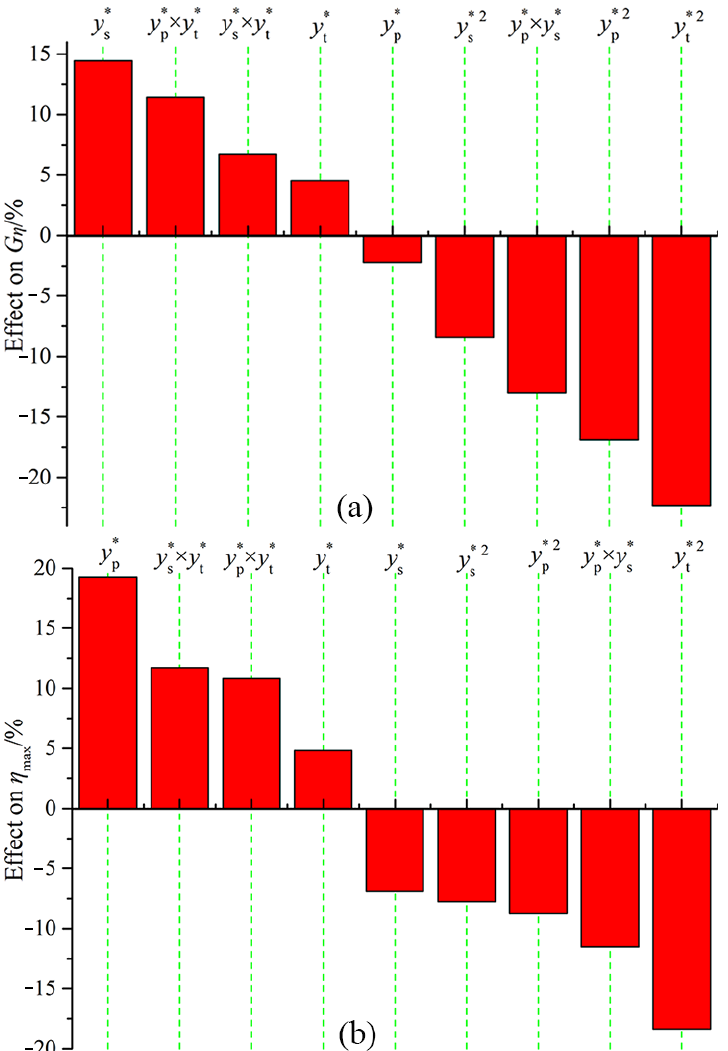
Figure 12. Pareto charts showing the first 9 primary effects for ( a ) G η , and ( b ) η max in the torque converter cascade parameters study.